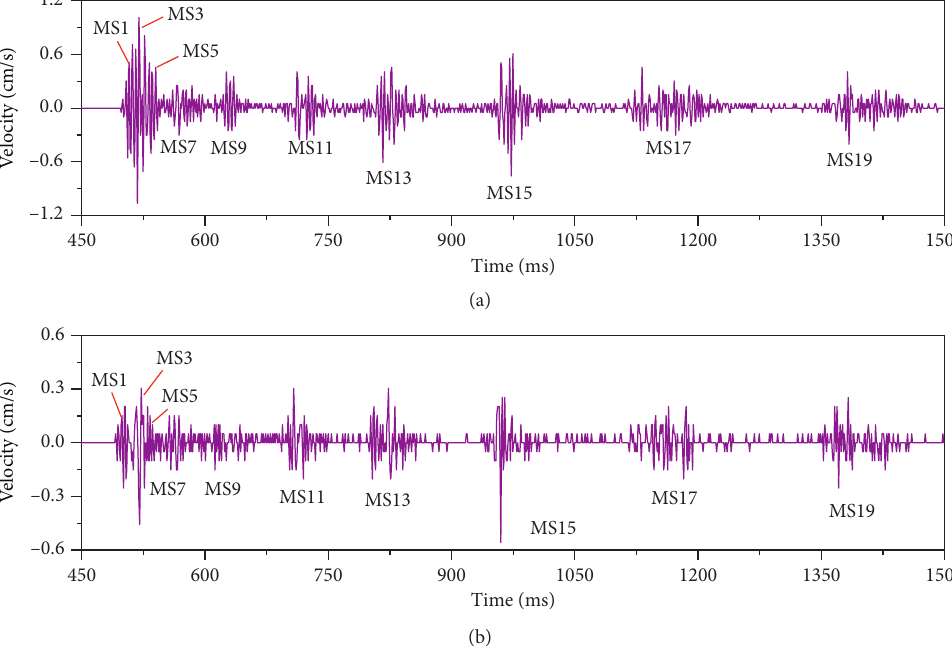
Figure 4: Time-history curves of the vertical vibration monitored during the blasting excavation of diversion tunnel #4 for the Jinping II hydropower station (monitoring points #2 and #3). (a) Monitoring point #2. (b) Monitoring point #3.